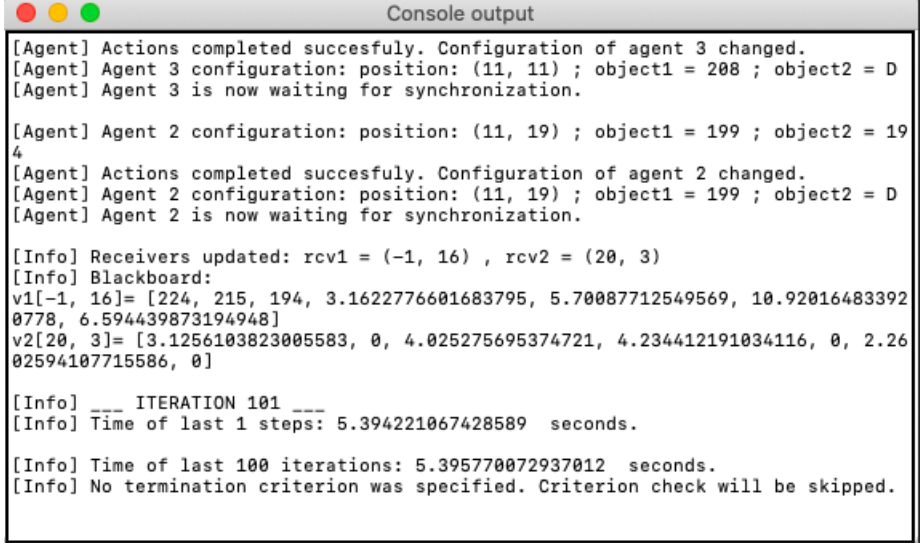
Figure 14. Console output redirected to the text field